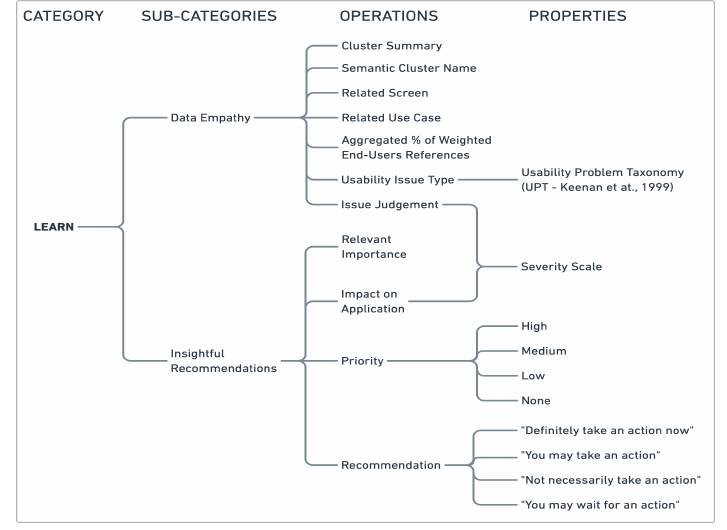
Figure 3. The learn category, sub-categories, operations, and